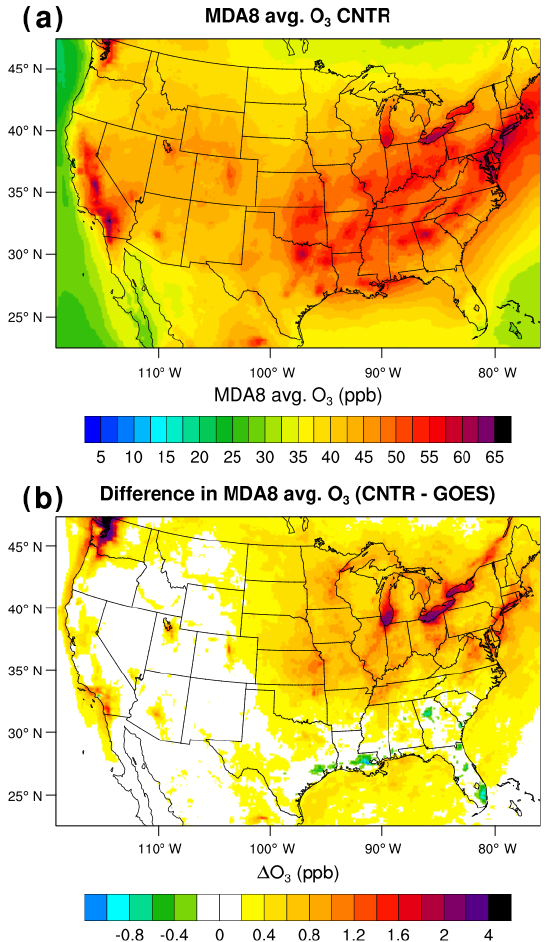
Figure 5. (a) Spatial distribution of maximum daily 8h average O 3 (MDA8 O 3 ) at the lowest model level averaged over the whole anal- ysis period in the CNTR simulation. (b) Difference in MDA8 O 3 at the lowest model level between the control and GOES simulations (i.e., CNTR minus